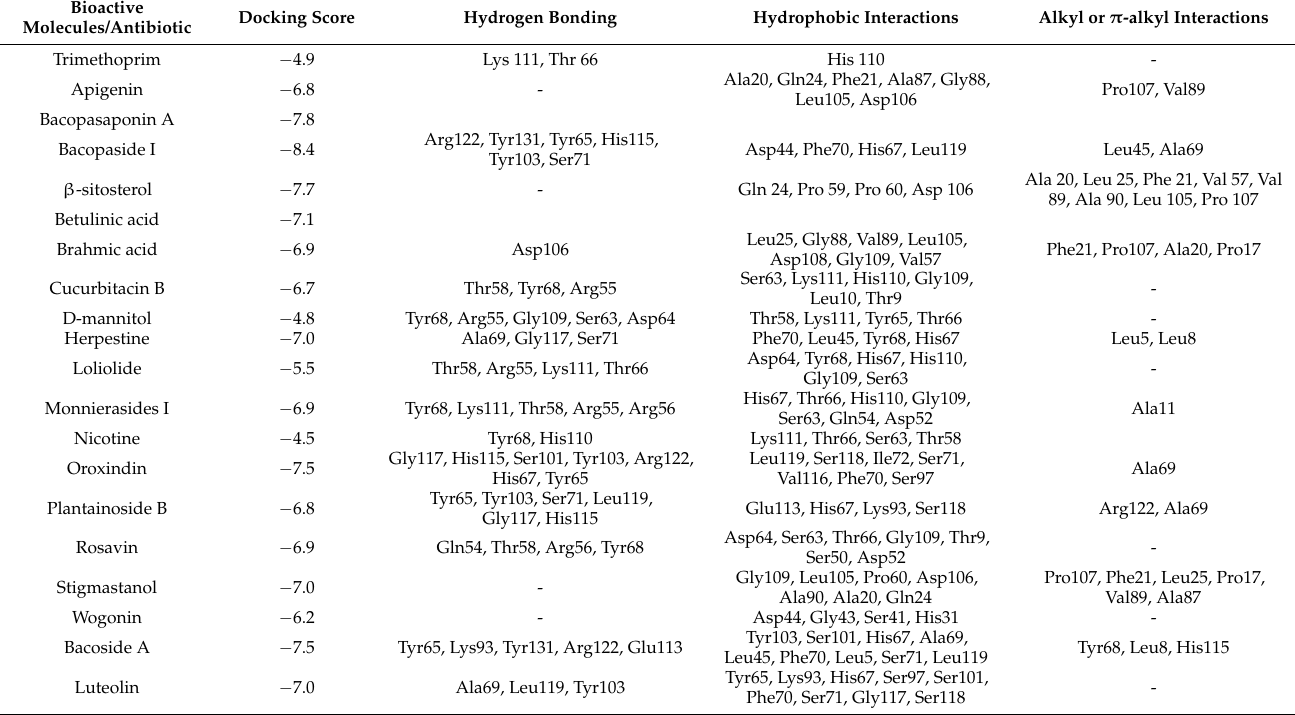
Table 3. Molecular docking analysis of major bioactive molecules from B. monnieri with